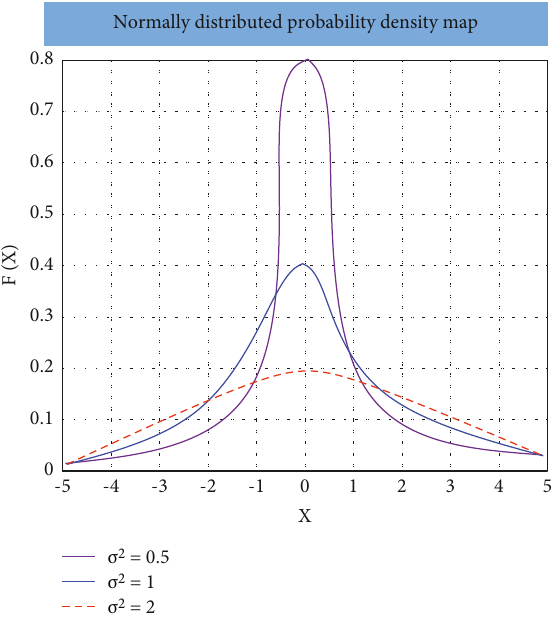
Figure 3: Normal distribution probability density